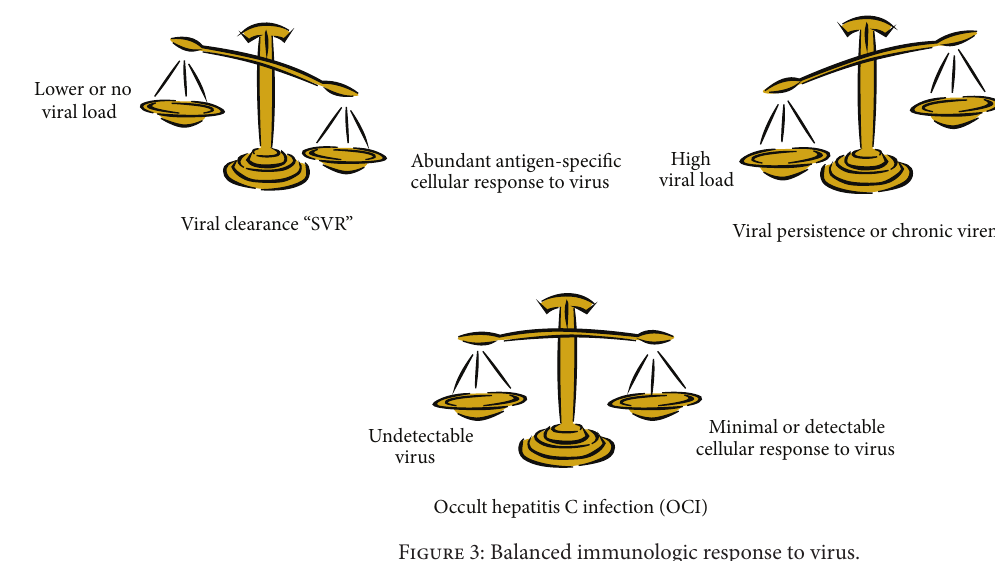
Figure 3: Balanced immunologic response to